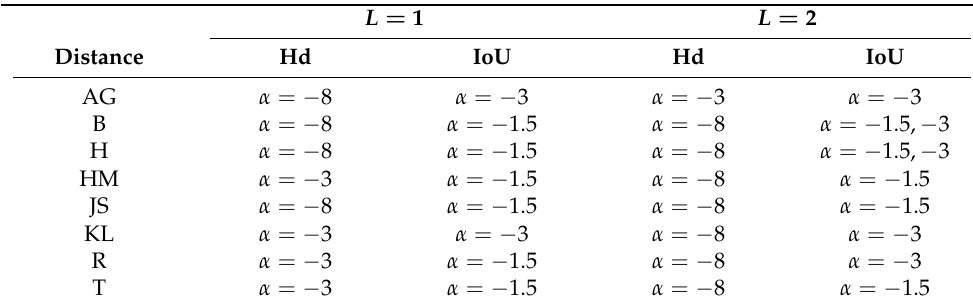
Table 3. Texture parameter in which the results of the detection technique are better according to the stochastic distance for synthetic